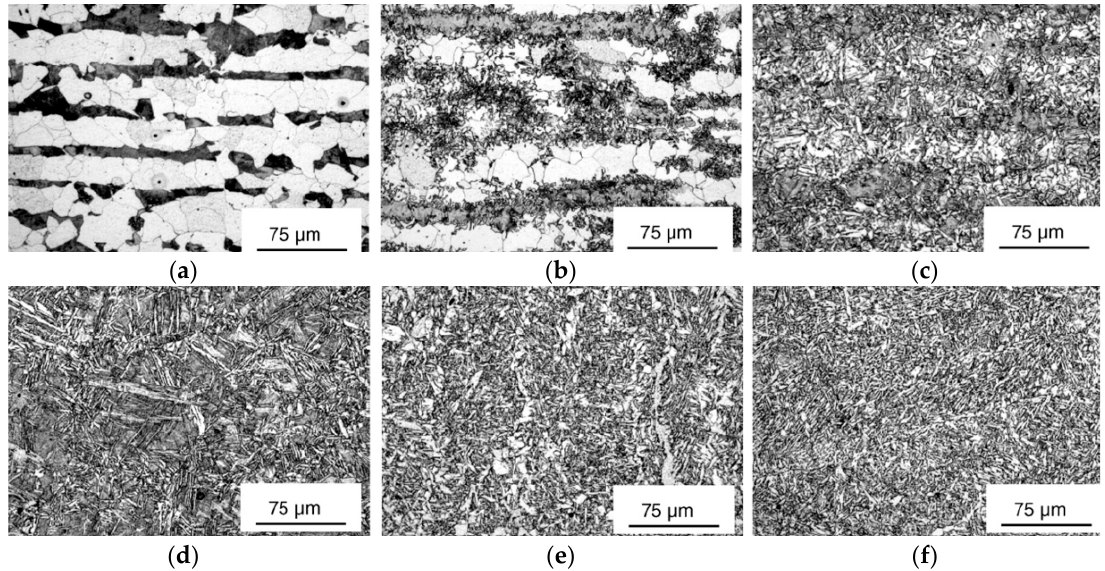
Figure 14. Microstructure evolution of the single pass hybrid followed by submerged arc: base material ( a ), partially recrystallized zone ( b ), fine grained zone ( c ), coarse grained zone ( d ), arc zone ( e ) and laser zone ( f ) (reproduced from [62] with permission, Elsevier, 2016).